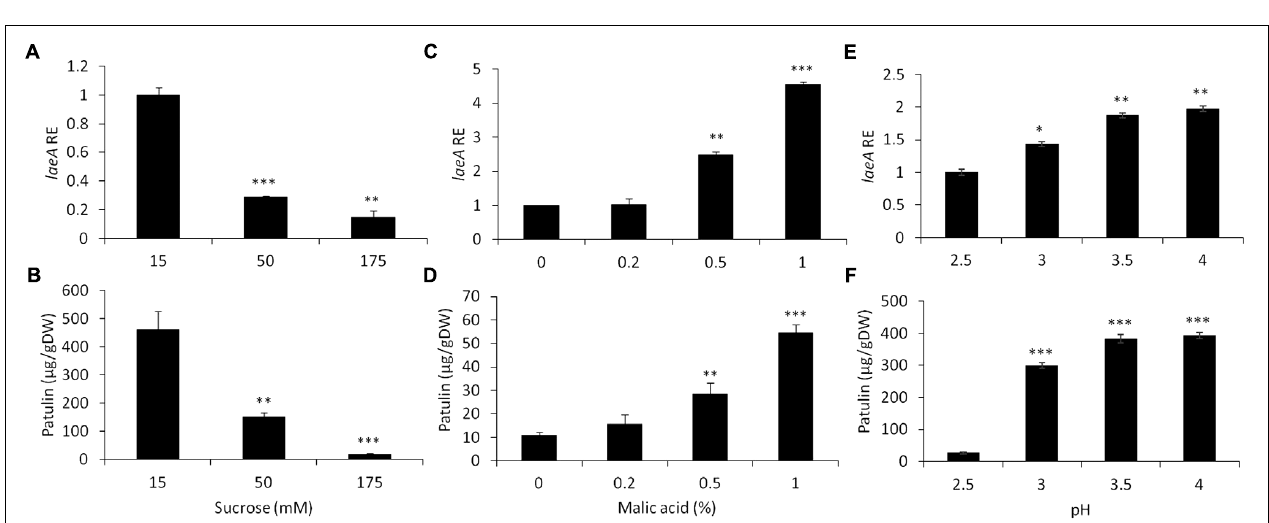
FIGURE 3 | Effect of sucrose, malic acid, and pH changes on the relative expression of laeA and patulin accumulation. Solid SM media at initial pH 5.0 was amended different concentrations of sucrose and malic acid and the pH of the SM media also brought to different pH values. The solid SM media was inoculated with 100 µ l of a 10 6 spore/ml suspension and laeA relative expression (A,C,E) and patulin accumulation (B,D,F) and were analyzed were evaluated 3 days post-inoculation. Five 10-mm diameter disks were sampled from five independent culture plates. Average value ( ± SE) of five replicate are reported. Experiments were repeated three times and results of a single representative experiments are shown. For statistical analysis, the unpaired student t -test was used with significance defined as a P value ( ∗ P ≤ 0.05; ∗∗ P ≤ 0.01; ∗∗∗ P ≤